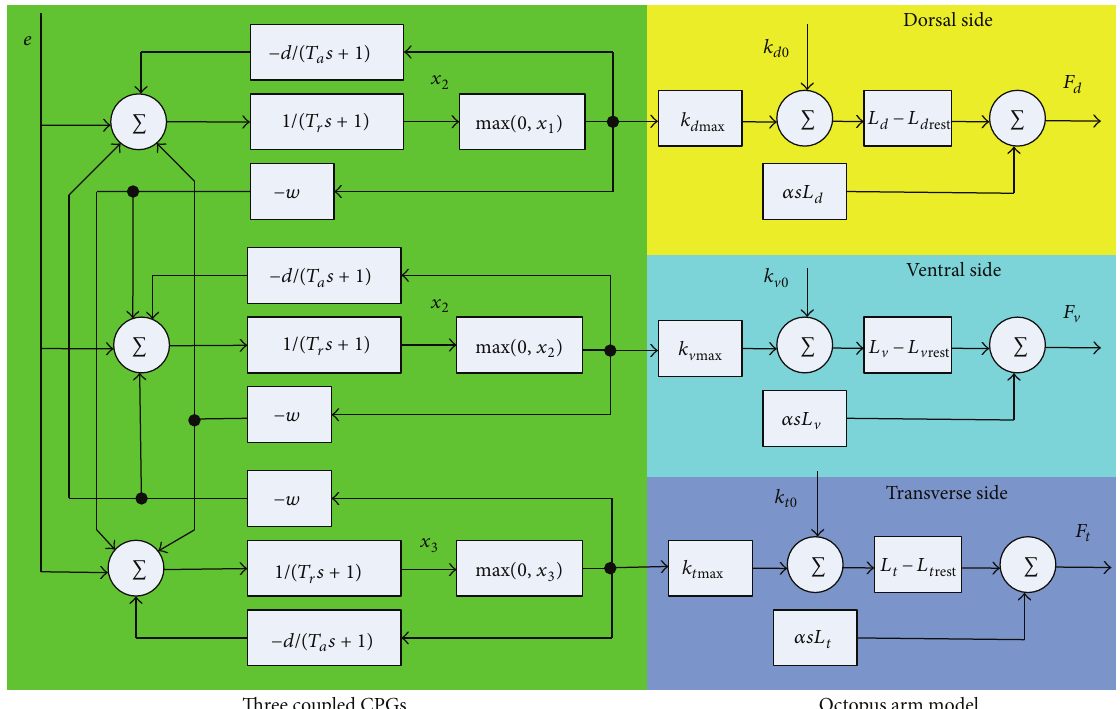
Figure 3: Model of interaction between the CPGs and the octopus arm.